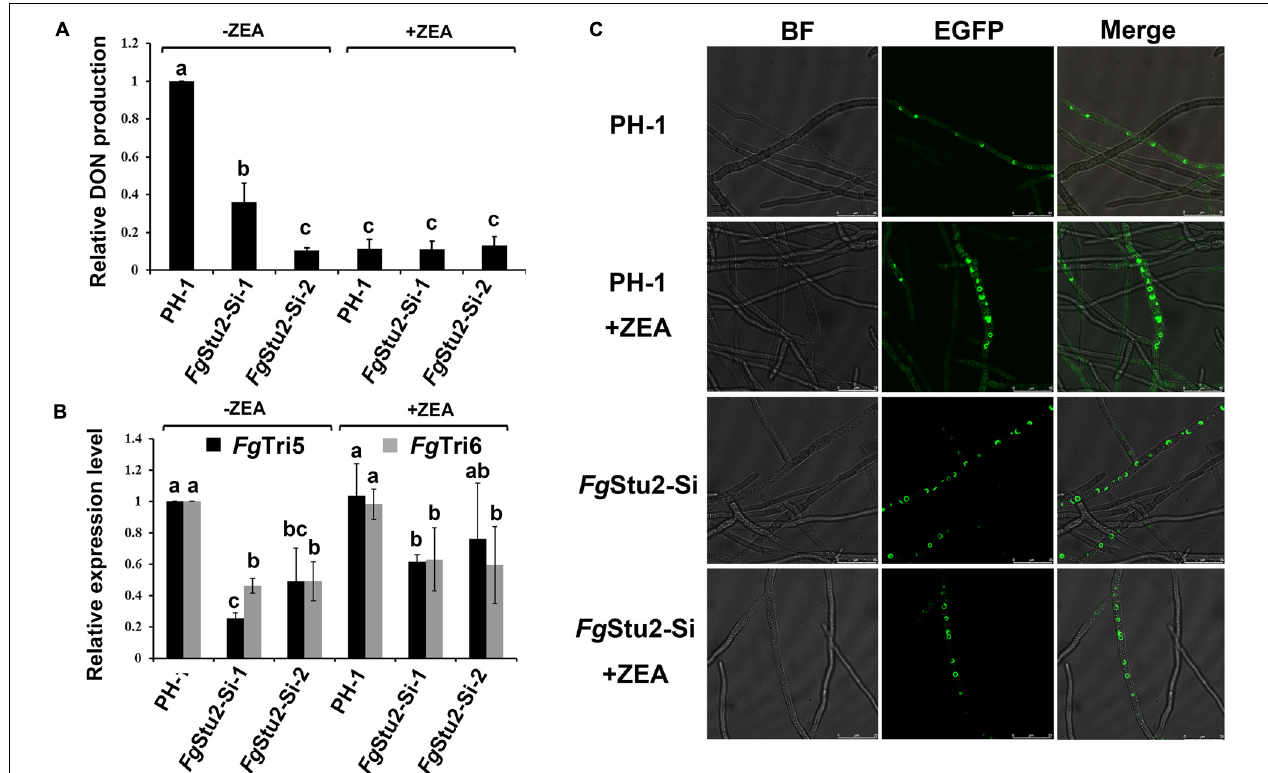
FIGURE 9 | Roles of Fg Stu2 gene in DON production. (A) Relative DON production of Fg Stu2-Si mutants. Wild-type strain PH-1 and Fg Stu2-Si mutants were inoculated into TBI medium with or without 30 µ M zearalenone (ZEA) and cultivate for 7 days at 28 ◦ C in the dark. DON production was tested using enzyme linked immunosorbent assay (ELISA). Means come from three independent assays. (B) Relative expression levels of Fg Tri5 and Fg Tri6 genes in Fg Stu2-Si mutants. Wild-type strain PH-1 was used as control. Wild-type strain PH-1 and Fg Stu2-Si mutants were inoculated into TBI medium with or without 30 µ M ZEA and cultivate for 3 days at 28 ◦ C in the dark. The fresh mycelium was used for total RNA extraction. Means come from three independent assays. (C) Fg Tri1-EGFP localization in wild-type strain PH-1 and Fg Stu2-Si mutants. PH-1-Tri1-EGFP and Fg Stu2-Si-Tri1EGFP strains were inoculated into TBI medium with or without 30 µ M ZEA and cultivate for 2 days at 28 ◦ C in the dark. The fresh mycelium was observed using a Leica SP8 laser confocal microscope. Bar = 25 µ m. This experiment was repeated three